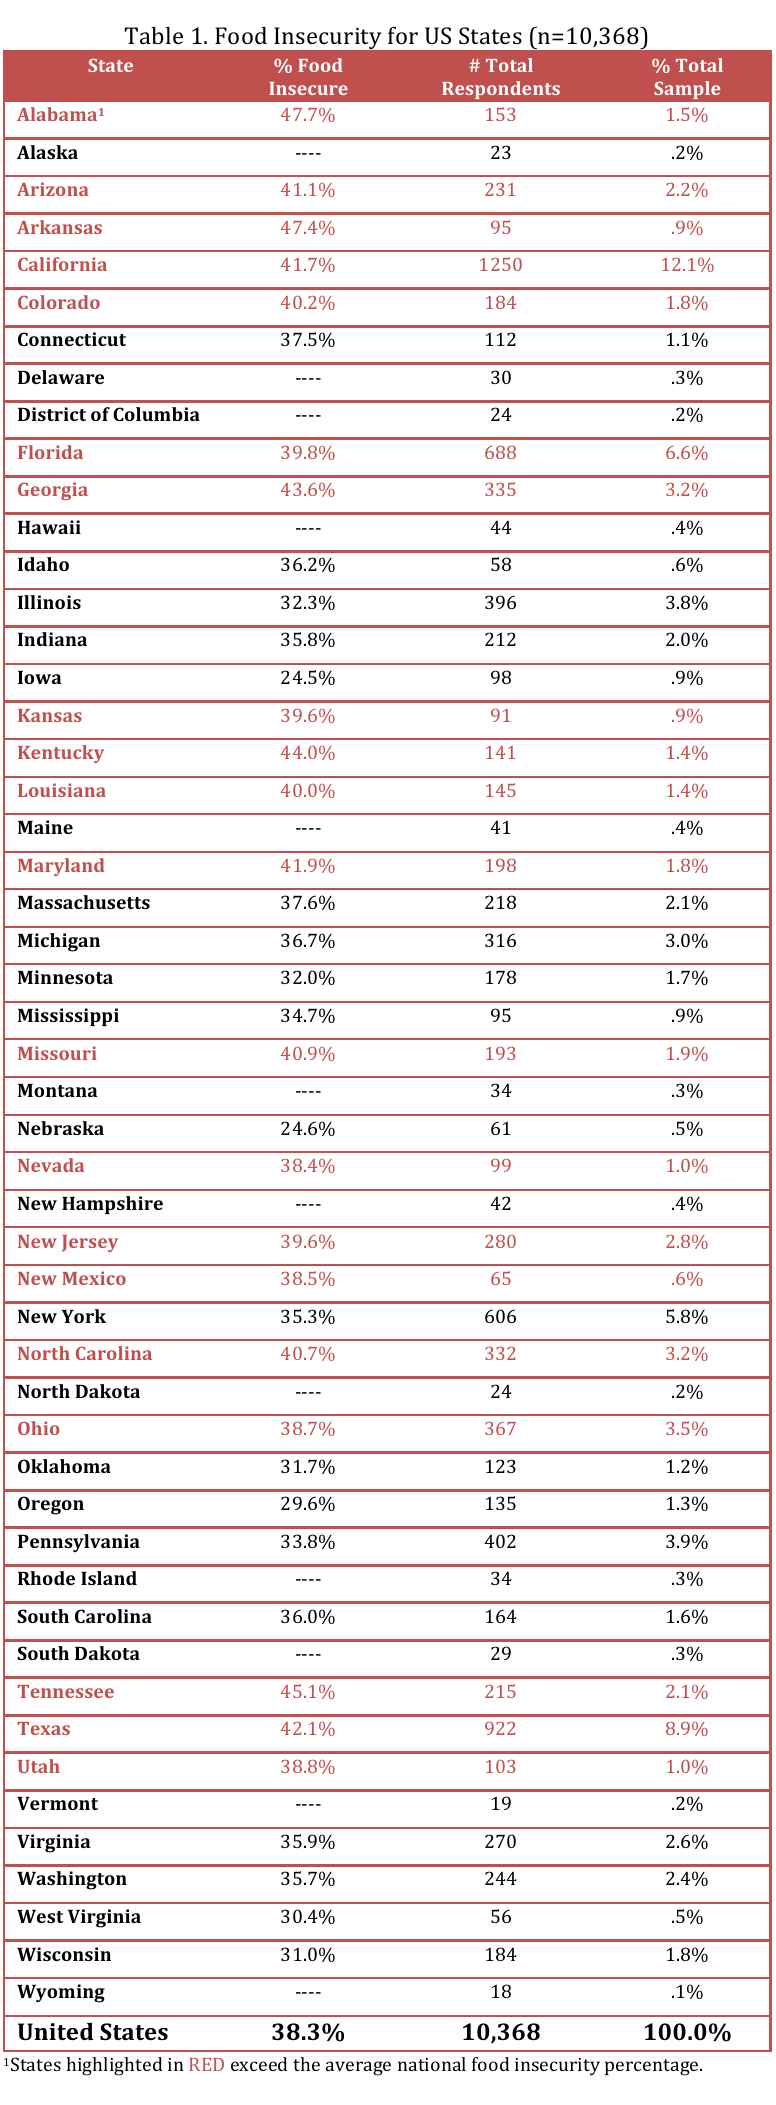
Table 1. Food Insecurity for US States